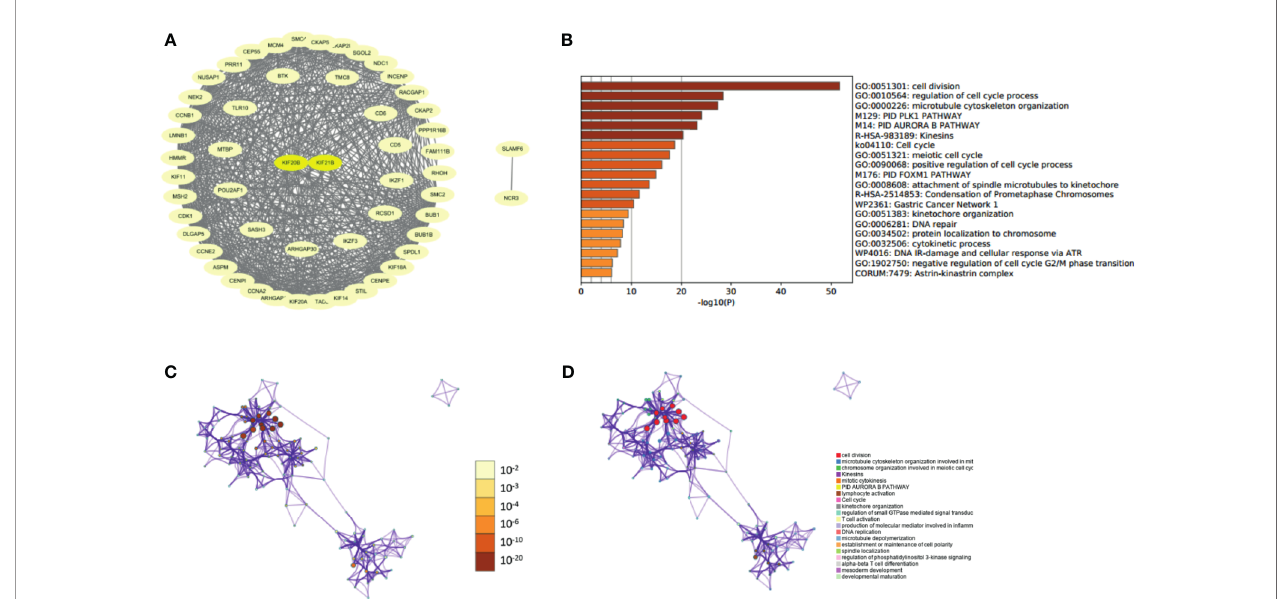
FIGURE 11 | Protein-protein interaction network and functional enrichment analysis of KIFs in patients with PAAD (STRING and Metascape). (A) PPI of prognosis- related KIFs and their similar genes. (B) Prognosis-related KIFs genes ontology (G.O.) enriched terms, colored by P -values. (C) Network of G.O. enriched terms colored by P -value, in which terms containing more genes tend to have a more signi fi cant P -value. (D) Network of G.O. enriched terms colored by cluster-ID, where nodes share the same cluster-ID are typically close to each